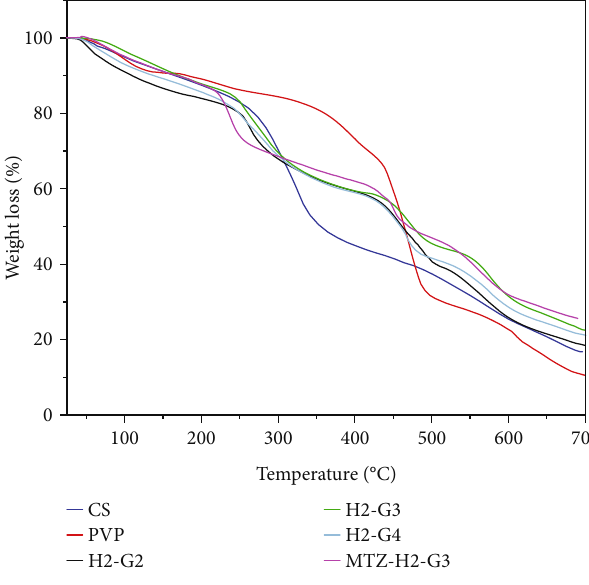
Figure 6: TGA thermograms of pristine CS and PVP, hydrogels H2-G2 to H2-G4 and